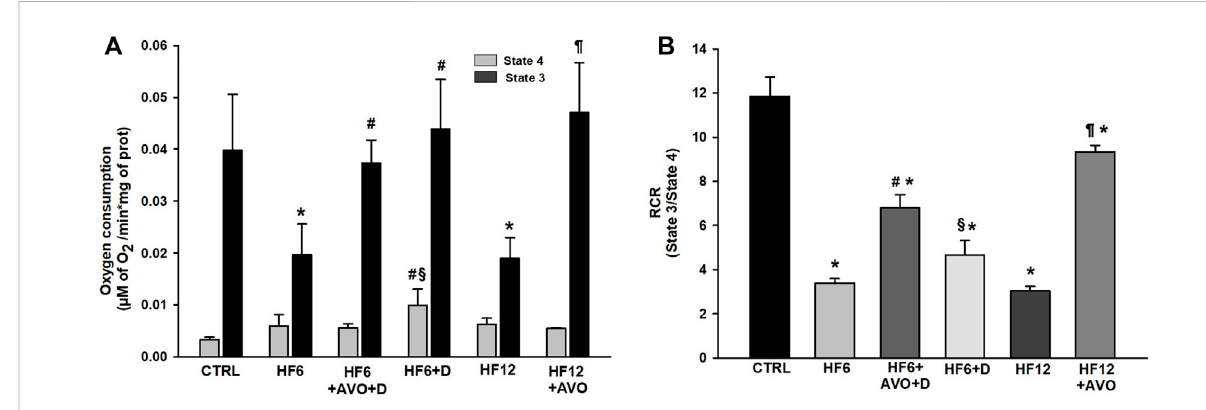
FIGURE 4 Effects of avocado oil on respiration (A) and respiratory control ratio (RCR) (B) Data are expressed as the mean ± standard error of n ≥ 4. * p < 0.05 vs. CTRL; # p < 0.05 vs. HF6; § p < 0.05 vs. HF6+AVO + D; p < 0.05 vs. HF12 (ANOVA, Holm- Š ídák ’ s post hoc test).